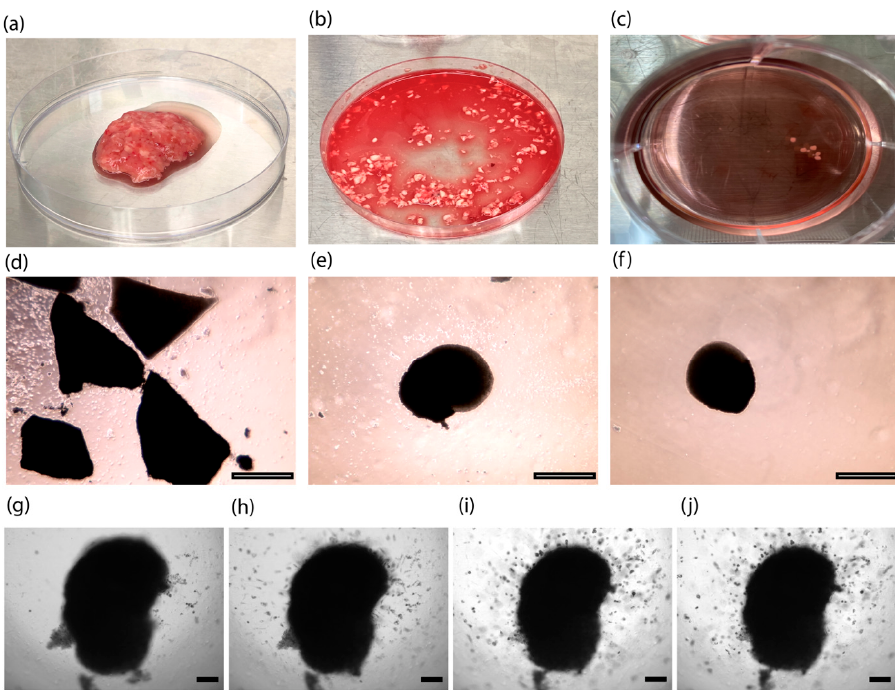
Figure 4. Development of GBOs from: ( a ) a tumor resected in the operating room coming as a bulk tumor, or ( b ) already dissociated in small pieces with a surgical blade until reaching less than 500 µm size. ( c ) Small pieces of tumor are forming GBOs after 15 days in the incubator. ( d ) GBOs are cut into small fragment pieces and incubated in media at t = 0. ( e ) GBOs after t = 7 days in culture media and under permanent shaking. ( f ) GBOs after t = 15 days in culture media and under permanent shaking. GBOs embedded in a matrix to verify invasion properties for ( g ) 0 h, ( h ) 24 h, ( i ) 120 h, and ( j ) 168 h. Scale bar from ( d ) to ( f ): 1000 µm, obtained with x2.5 objective lens, under Evos microscope. Scale bar from ( g ) to ( j ): 200 µm, brightfield images were recorded on Cytation 5, using a 4× objective lens.